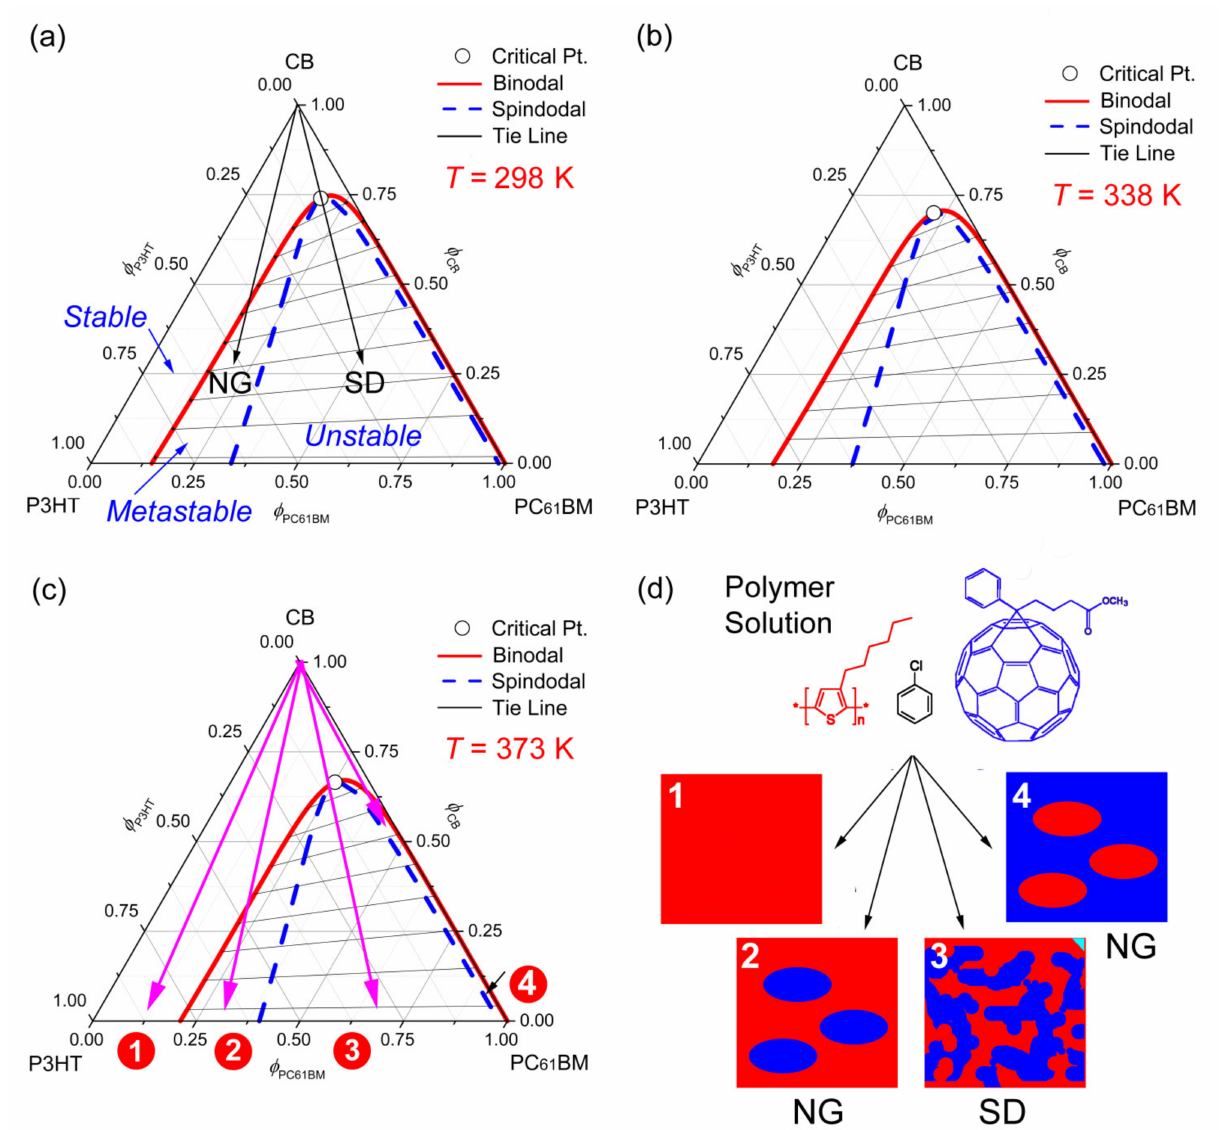
Figure 3. Phase diagrams for the ternary CB/P3HT/PC 61 BM system as a function of temperature. ( a ) T = 298 K: χ 12 = 0.45, χ 13 = 0.90, and χ 23 = 1.50. ( b ) T = 338 K: χ 12 = 0.44, χ 13 = 0.83, and χ 23 = 1.36. ( c ) T = 373 K: χ 12 = 0.43, χ 13 = 0.78, and χ 23 = 1.27. Here, for P3HT, M n = 22 kg/mol, s = 0.005071 and r = 0.167068. ( d ) A schematic explanation for a film-forming process through the four cases: (1) Single homogeneous phase. (2) Nucleation and growth of the polymer-rich phase. (3) Spinodal decomposition. (4) Nucleation and growth of the polymer-lean